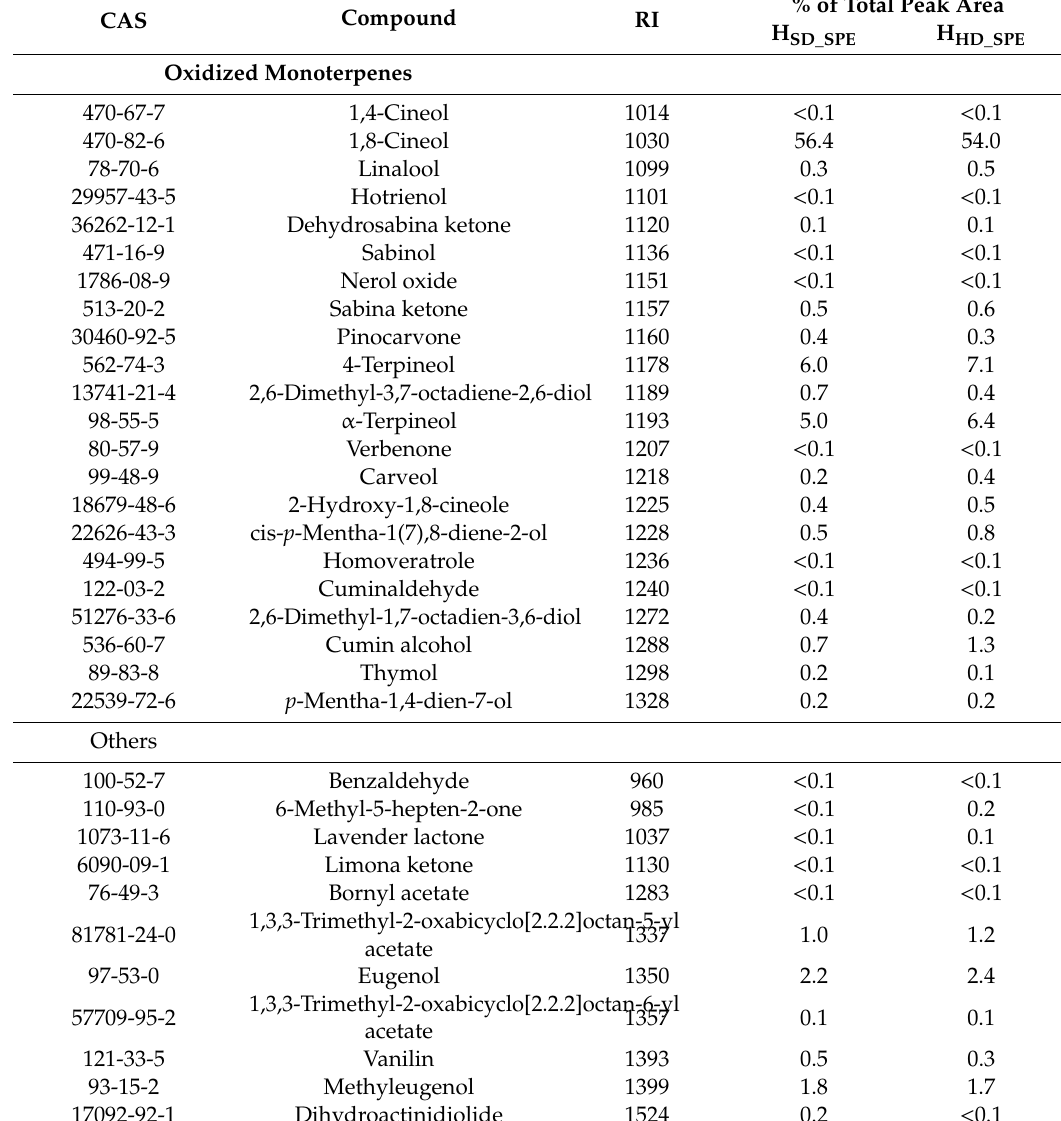
Table 3. List of compounds identified in hydrolate extracts from Laurus nobilis